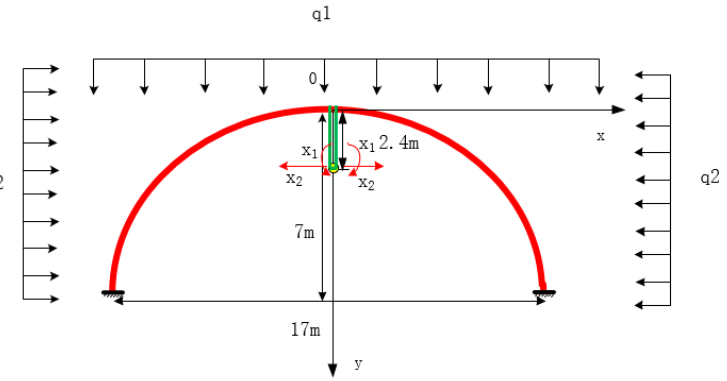
Figure 6. Analysis model under conventional load.